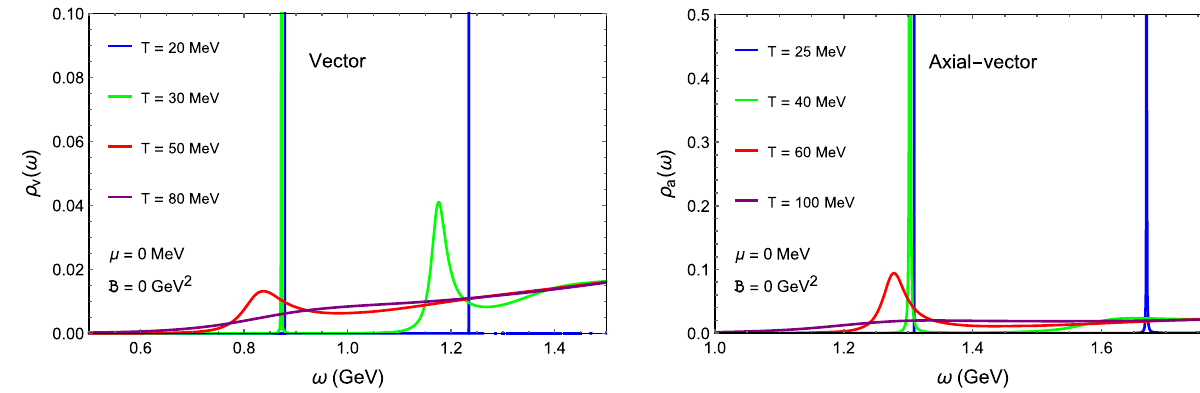
Fig. 4 The spectral functions ρ v (ω) and ρ a (ω) for four different temperatures at μ = B = 0